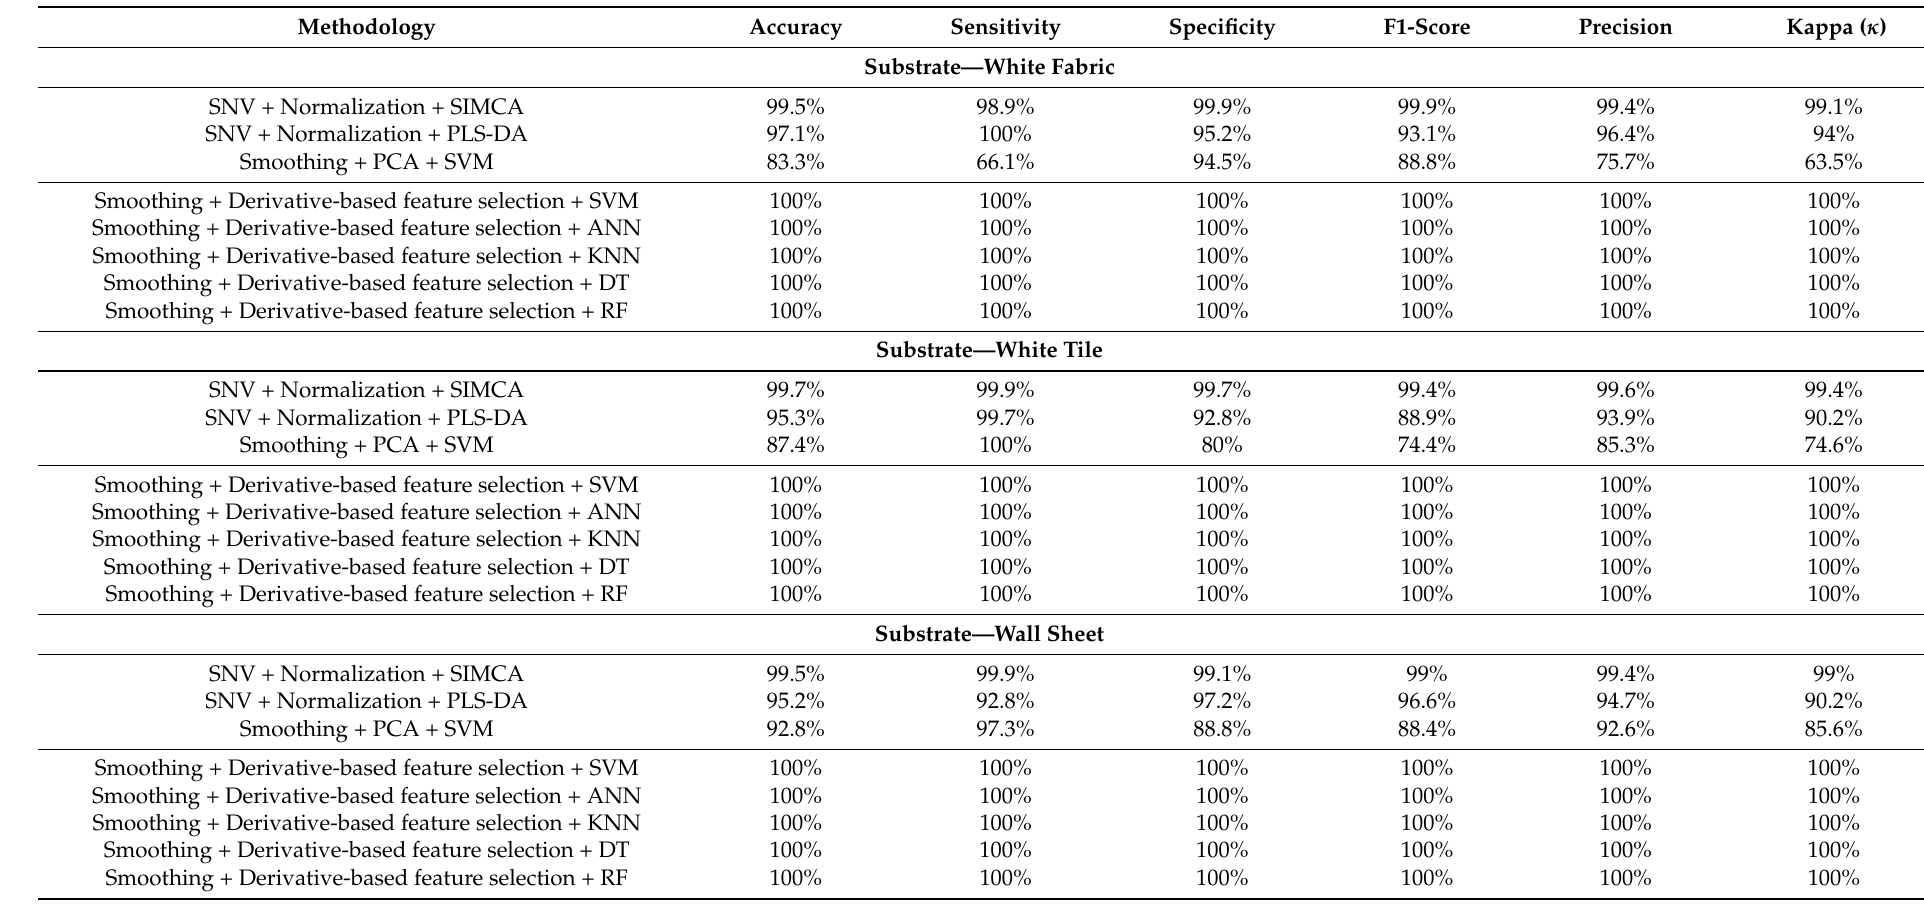
Table 9. Comparison of a proposed pipeline with state-of-the-art methodologies in which SNV stands for Standard Normal Variate, SIMCA stands for Soft Independent Modeling of Class Analogy, and PLS-DA stands for Partial-Least Squares Discriminant